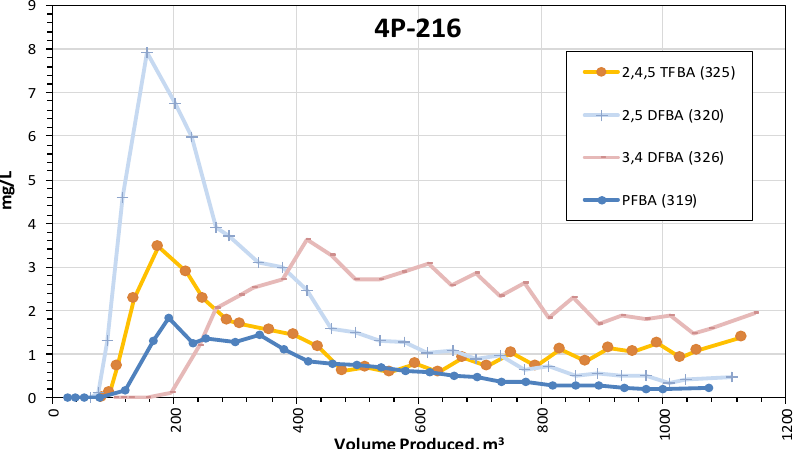
Figure A10. Tracer breakthrough curves as a function of volume produced in well 4P-216. Legend indicates number of the well into which each tracer was injected.